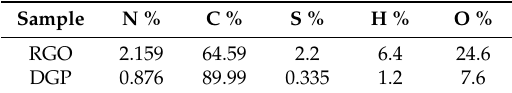
Table 1. Results of elemental analysis of RGO and DGP